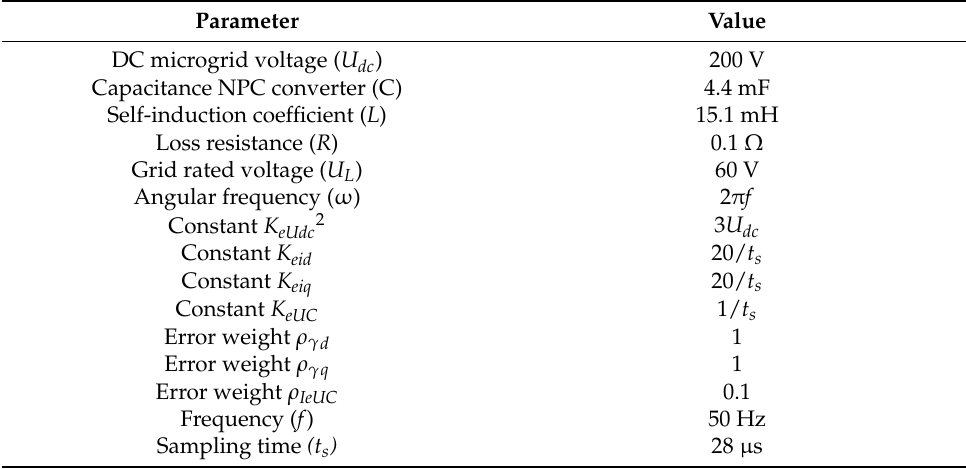
Table 1. Hybrid microgrid parameters and